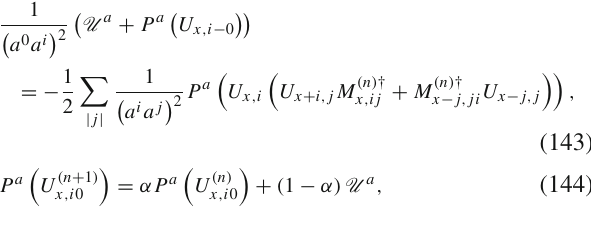
Fig. 3 Left: the Wilson lines associated with the properly time- averaged field strength M x , ij used in the implicit scheme. Right: the Wilson lines associated with the partially averaged field-strength W x , 1 i used in the semi-implicit scheme. Spatial link variables are drawn as solid black arrows; temporal links as dashed arrows. The shaded planes represent(equal)timeslices,i.e.thespatiallattice(onlytwodimensions shown) in subsequent time steps. The averaged field-strength M x , ij has